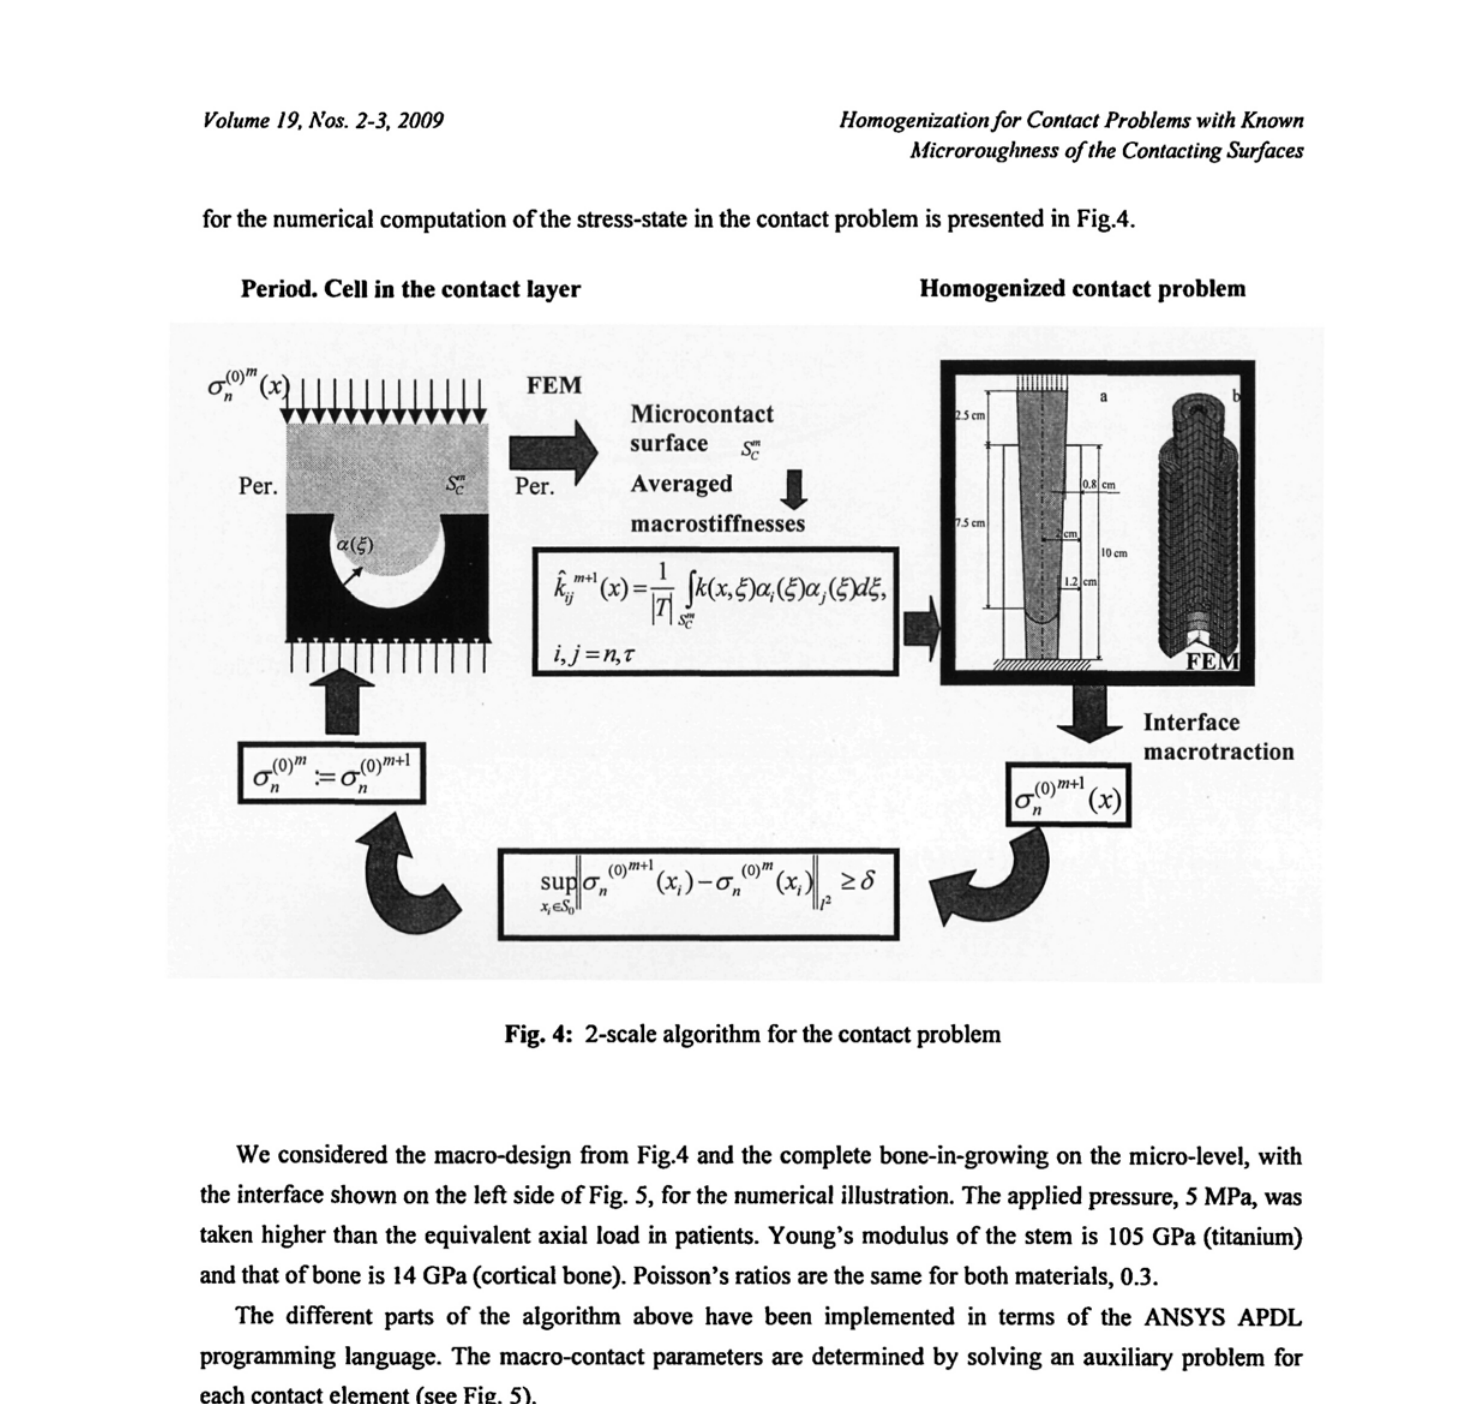
Fig. 4: 2-scale algorithm for the contact